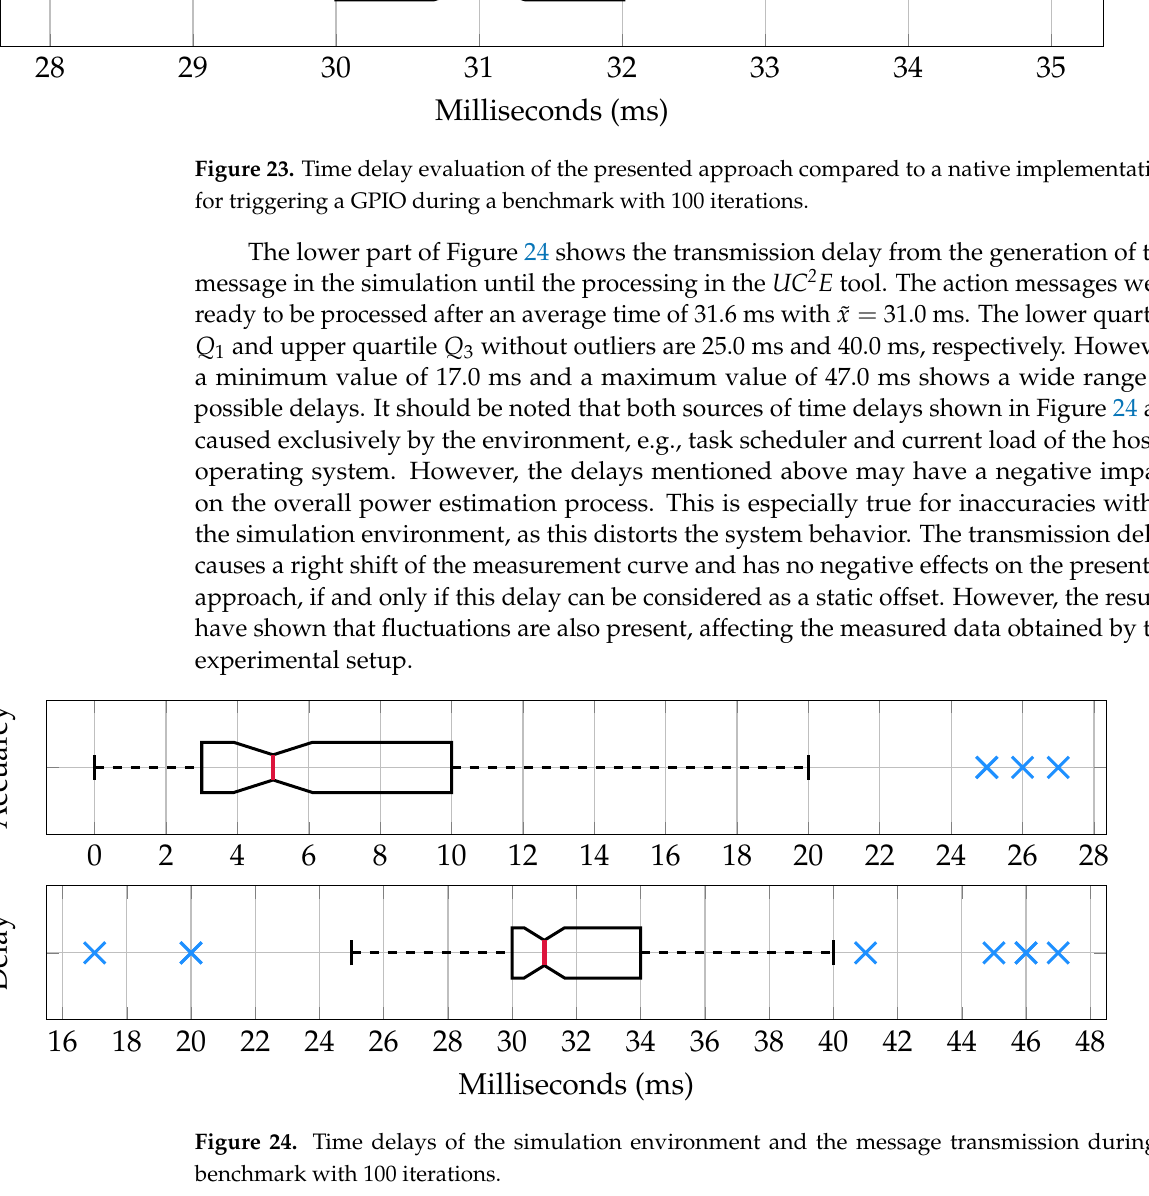
Figure 24. Time delays of the simulation environment and the message transmission during a benchmark with 100 iterations.